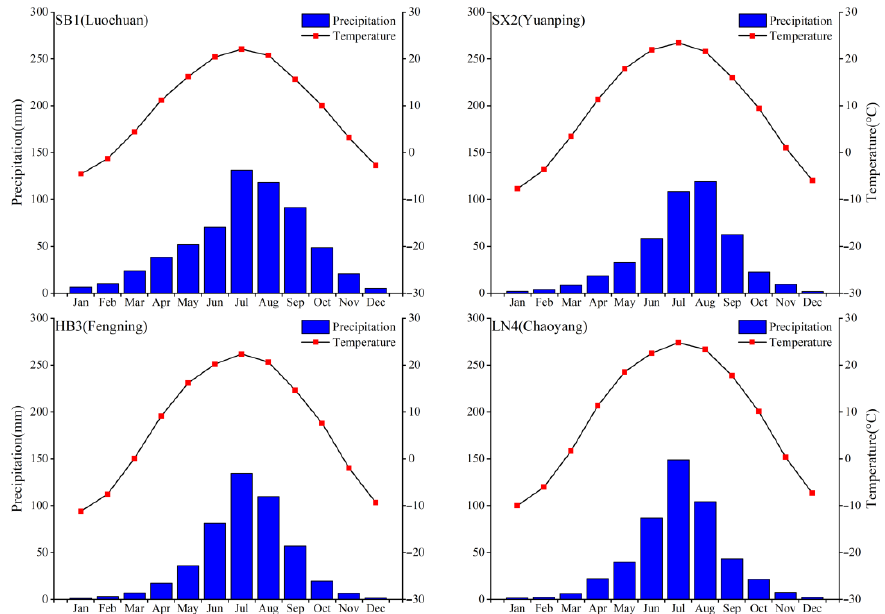
Figure 2. Variations in monthly mean temperature (red dot) and precipitation (blue bar) from the four meteorological stations used for each site. four meteorological stations used for each